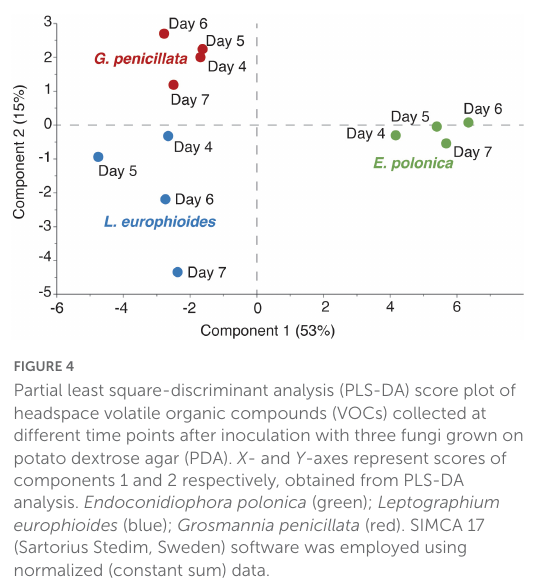
FIGURE4 Partial least square-discriminant analysis (PLS-DA) score plot of headspace volatile organic compounds (VOCs) collected at different time points after inoculation with three fungi grown on potato dextrose agar (PDA). X - and Y -axes represent scores of components 1 and 2 respectively, obtained from PLS-DA analysis. Endoconidiophora polonica (green); Leptographium europhioides (blue); Grosmannia penicillata (red). SIMCA 17 (Sartorius Stedim, Sweden) software was employed using normalized (constant sum) data. acetate ranged from 1,000 to 5,500 ng/h/Petri dish, and from 200 to 1,500 ng/h/Petri dish, respectively, at an 8:1 ratio on day 4 and 3:1 on day 7. In L. europhioides , acetates were detectable only from day 6, with a 300 ng/h/Petri dish of 3-methyl-1-butyl acetate and 30 ng/h/Petri dish of 2-methyl-1-butyl acetate at a 9:1 ratio. In G. penicillata , only 3-methyl-1-butyl acetate was detected on day 6 in a 35 ng/h/Petri